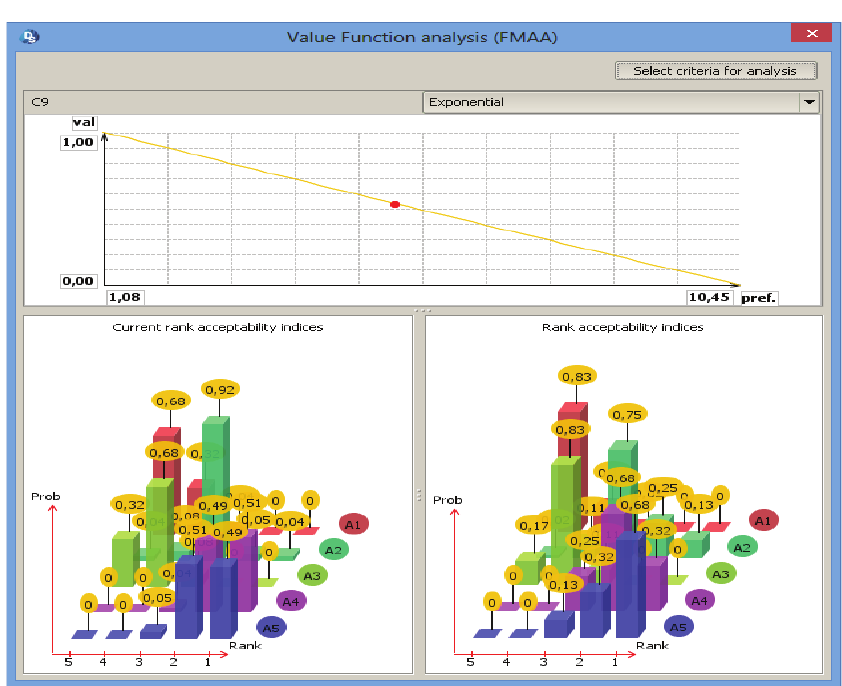
Fig.13. DecernsMCDA : value function sensitivity analysis in